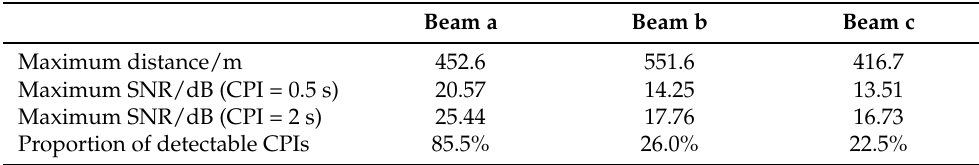
Table 5. Detection performance of different